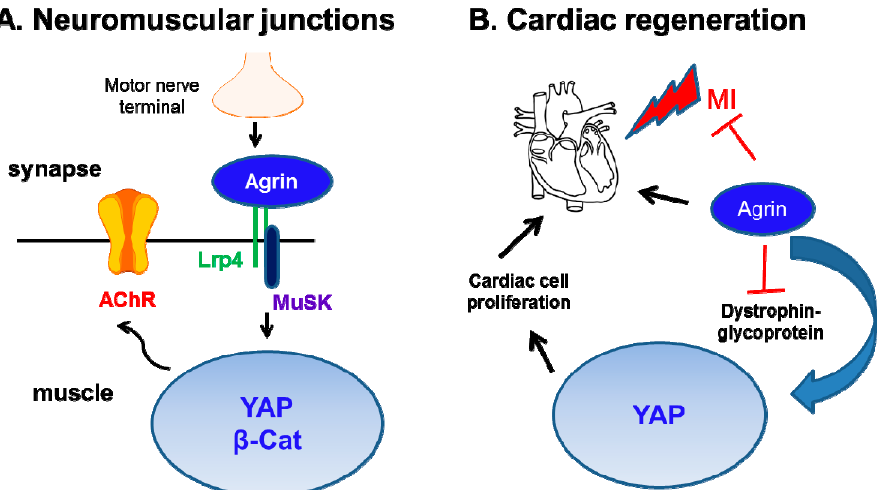
Figure 7. Concerted agrin and YAP activity in the maintenance of NMJs and promoting cardiac regeneration. ( A ) Agrin secretion from motor nerve terminal activates Lrp4-MuSK signaling. This potentiates YAP and possibly β -catenin activity in the nucleus of muscle cells, thereby, aggregating Acetylcholine receptors (AchR) and propagating nerve impulse to the muscle cells. ( B ) Though adult hearts have minimal agrin expression compared to that during neonatal stages, stimulation with recombinant agrin has protective values against myocardial infarction (MI) in adult mice hearts. Mechanistically, agrin binds to and inhibits dystroglycan complex, thereby, shifting YAP into the nucleus to engage cardiomyocyte proliferation and regeneration.